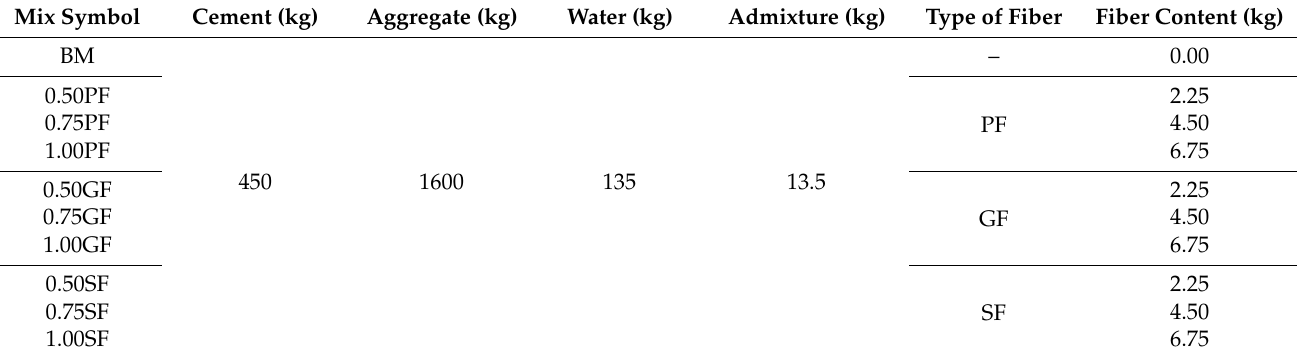
Table 5. Mix proportions (1 m 3 ).